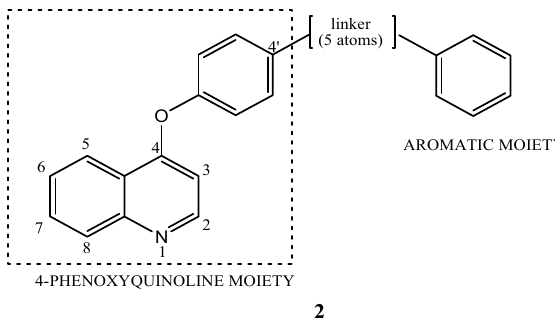
Figure 5. General structure for quinoline c-Met inhibitors as analogues of cabozantinib and foretinib .